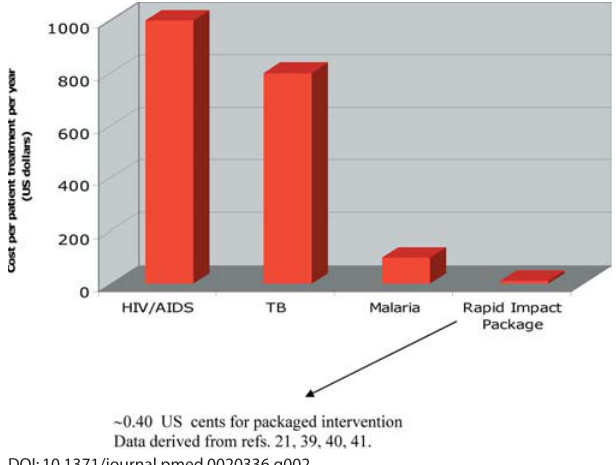
Figure 2. Range of Treatment Costs Per